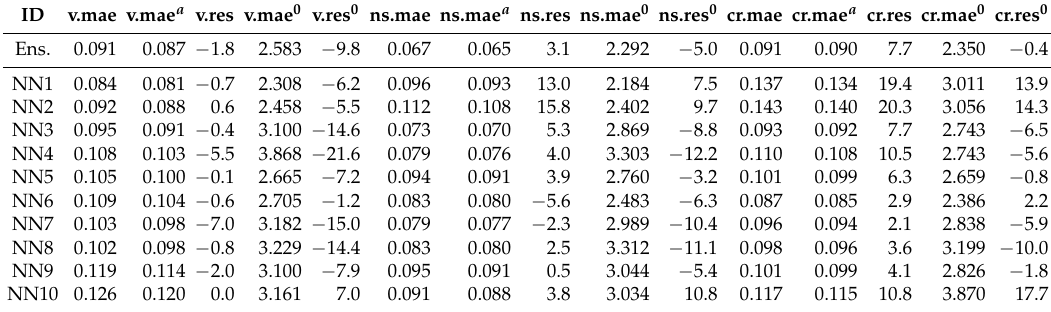
Table 5 confirms these results with respect to the reduced nested stochastics and capital region sets. Table 5. Validation figures for the ensemble and the 10 best performing neural networks after the exclusion of the points with scenarios outside of the fitting space. MAEs in